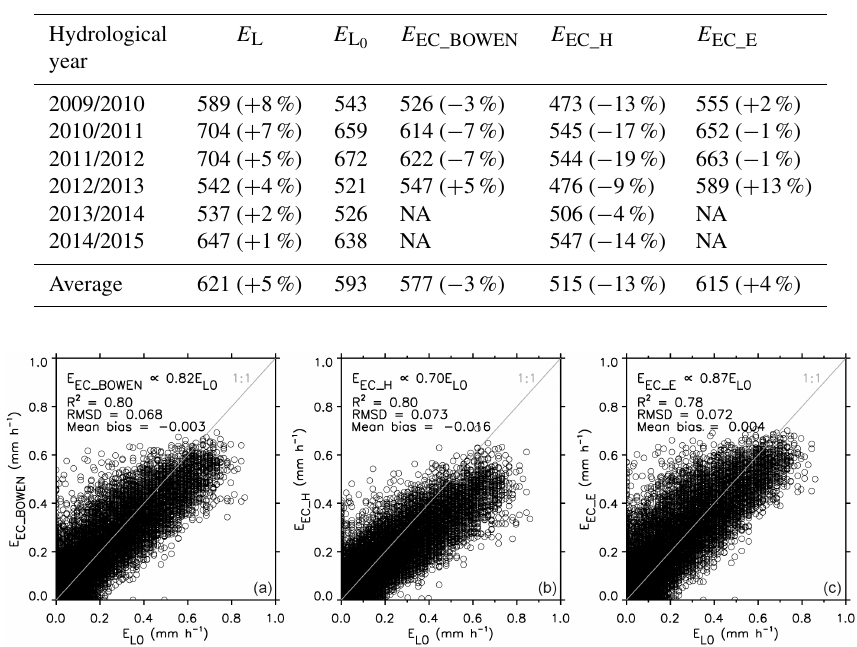
Table 2. Lysimeter ( E L and E L ) and EC ( E EC ) evapotranspiration (including E EC corrected according to the Bowen ratio ( E EC_BOWEN ), 0 and E EC corrected by assigning the energy balance closure gap to sensible heat-flux only ( E EC_H ) and to latent heat-flux only ( E EC_E )) for 6 hydrological years and the respective 6-year averages. Percentages denote the differences of E EC and E L to E L and 2014/2015 an energy gap correction is not possible for a 4-month period due to missing soil heat flux (see Sect. 2.5) and thus E EC_BOWEN and E EC_E are not available (denoted as NA in the table). Units in mmyr − 1 .